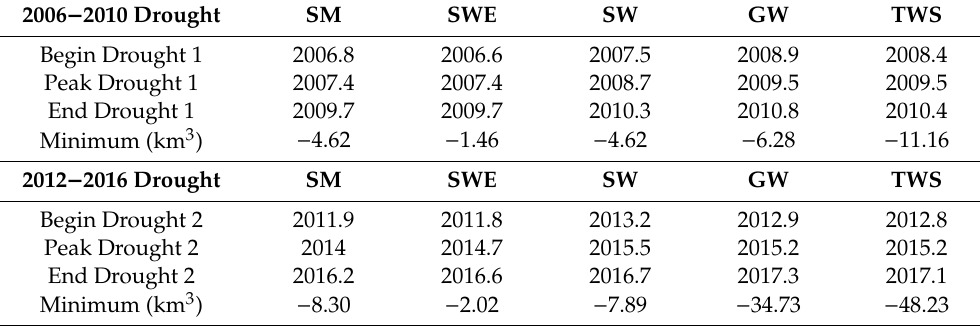
Table 2. Timing of the beginning, the peak, and the end of each drought period for each of the components of the hydrologic cycle. Also included are the peak magnitudes of water loss for each component during each drought (in km 3 ).